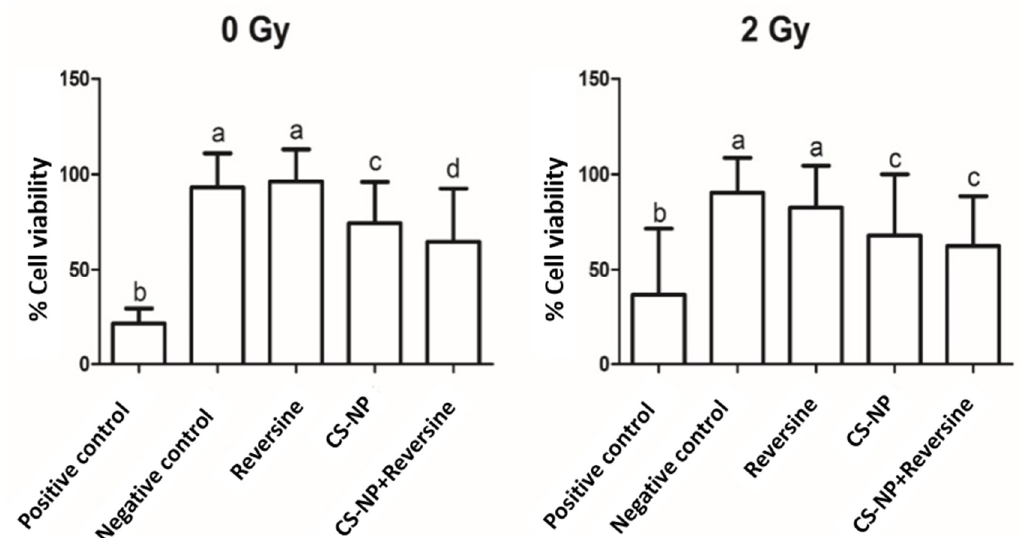
Figure 3. E ff ect of ionising radiation (2 Gy) on MCF-7 cell viability. Non-irradiated (0 Gy) MCF-7 cells were used as negative control, whereas MCF-7 cells treated with 100 µ M of H 2 O 2 to induce DNA damage following X-ray irradiation were used as positive control. The bars represent the mean value of three independent experiments, and the lines represent the standard deviation. Bars with same letter (a, b, c, d) are not significantly di ff erent (Tukey > 0.05). Non-irradiated (0 Gy) samples: negative